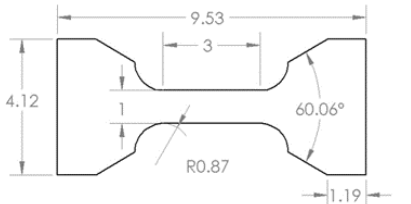
Figure 2. Dimension of the miniature tensile specimen. Units are in mm.